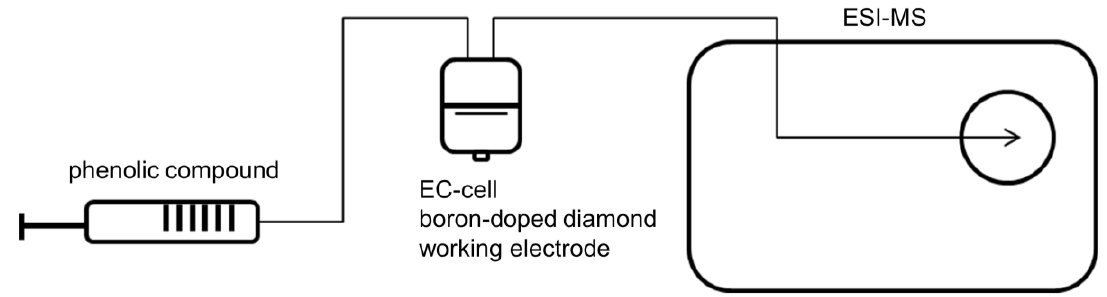
Figure 5. Instrumental setup for oxidation of phenolic acids by EC/ESI-MS. Phenolic acids are oxidized electrochemically via thin-layer cell including boron-doped diamond working electrode and are directly infused to ESI-MS.